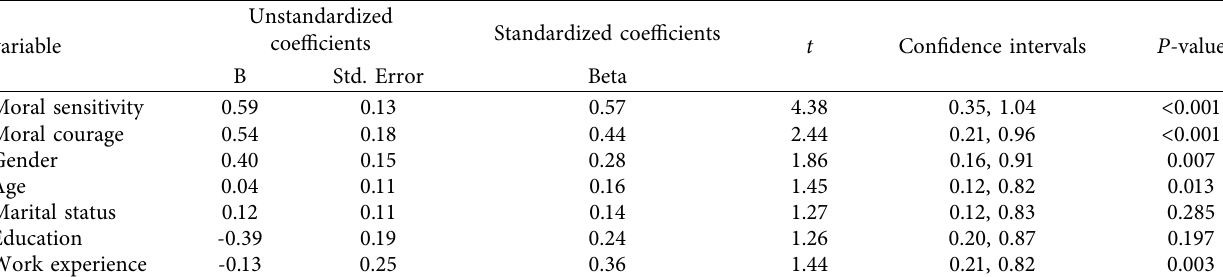
Table 3: Predictors of safe care in special care